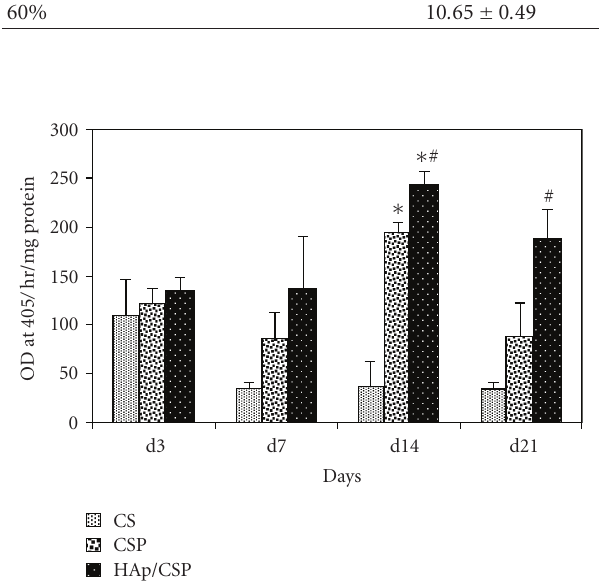
Figure 7: AP activity of osteoblast cells grown on CSP and HAp/CSP films, CS was taken as control. Both in case of CSP and HAp/CSP enzyme activity increased up to day 14 ( P < . 001). HAp/CSP nanocomposite is proven a better support for osteoblast di ff erentiation than CSP alone ( P < . 01).